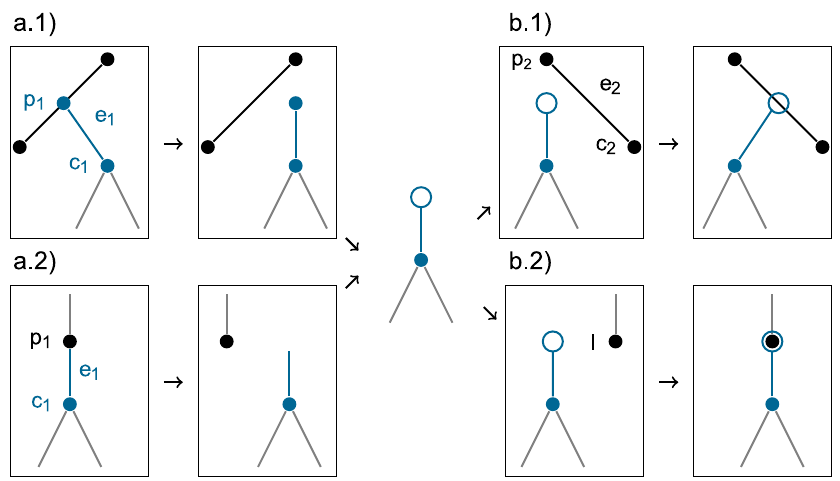
Figure 2. The Wilson Balding operator. The operator proposes a sampled ancestor tree topology and node ages and may propose a tree of larger or smaller dimension (the number of nodes in the tree) than the original tree. First, it prunes a subtree rooted at edge e 1 (blue edge) either from a branch, coloured black, in case a.1 or from a node, coloured black, in case a.2. Then it attaches the subtree either to an edge e 2 (black edge) at a random height in case b.1 or to a leaf l (black node) in case b.2. Case a.1 followed by b.2 removes a node from the tree and case a.2 followed by b.1 introduces a new node into the tree.